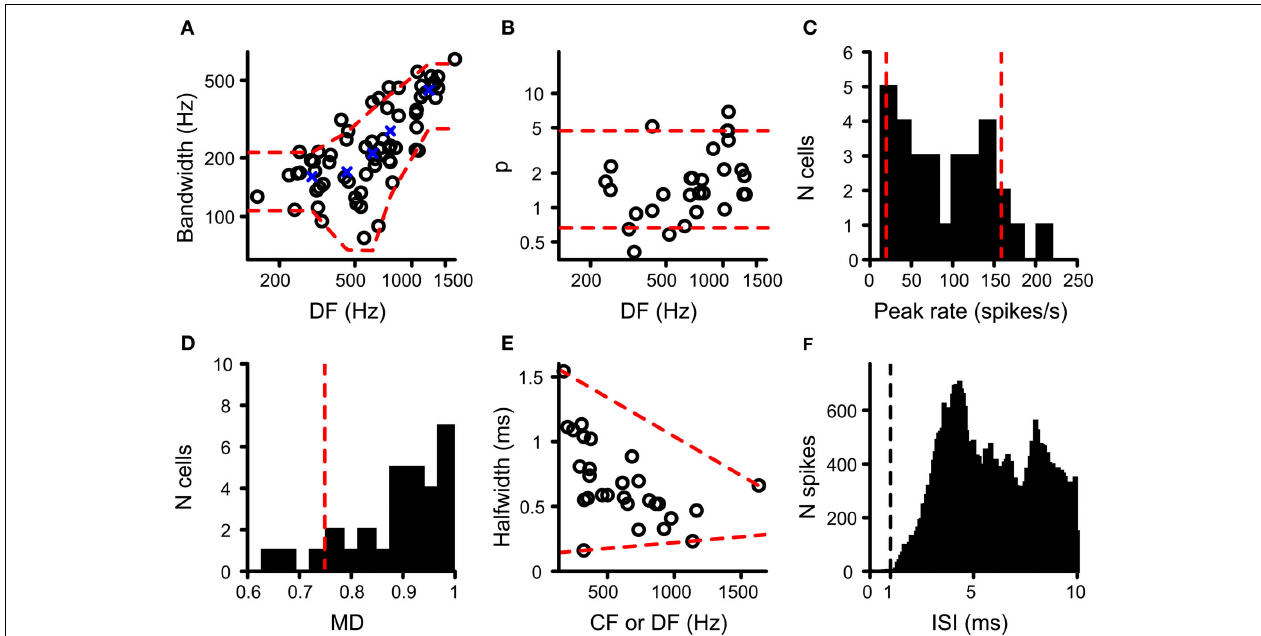
FIGURE 3 | Data from binaural cells used to constrain simulation output. Red dashed lines indicate the parameter range accepted for coincidence simulation output (see text for details). (A) Scatter plot of bandwidth vs. DF for cat IC datasets (circles; n = 68). (B) Power of rICF as a function of DF for cat IC ( n = 29). Data in (A) and (B) taken from (Mc Laughlin et al., 2008, 2014). (C) Histogram of peak firing rate of chinchilla LL noise delay functions ( n = 30). (D) Histogram of modulation depth of